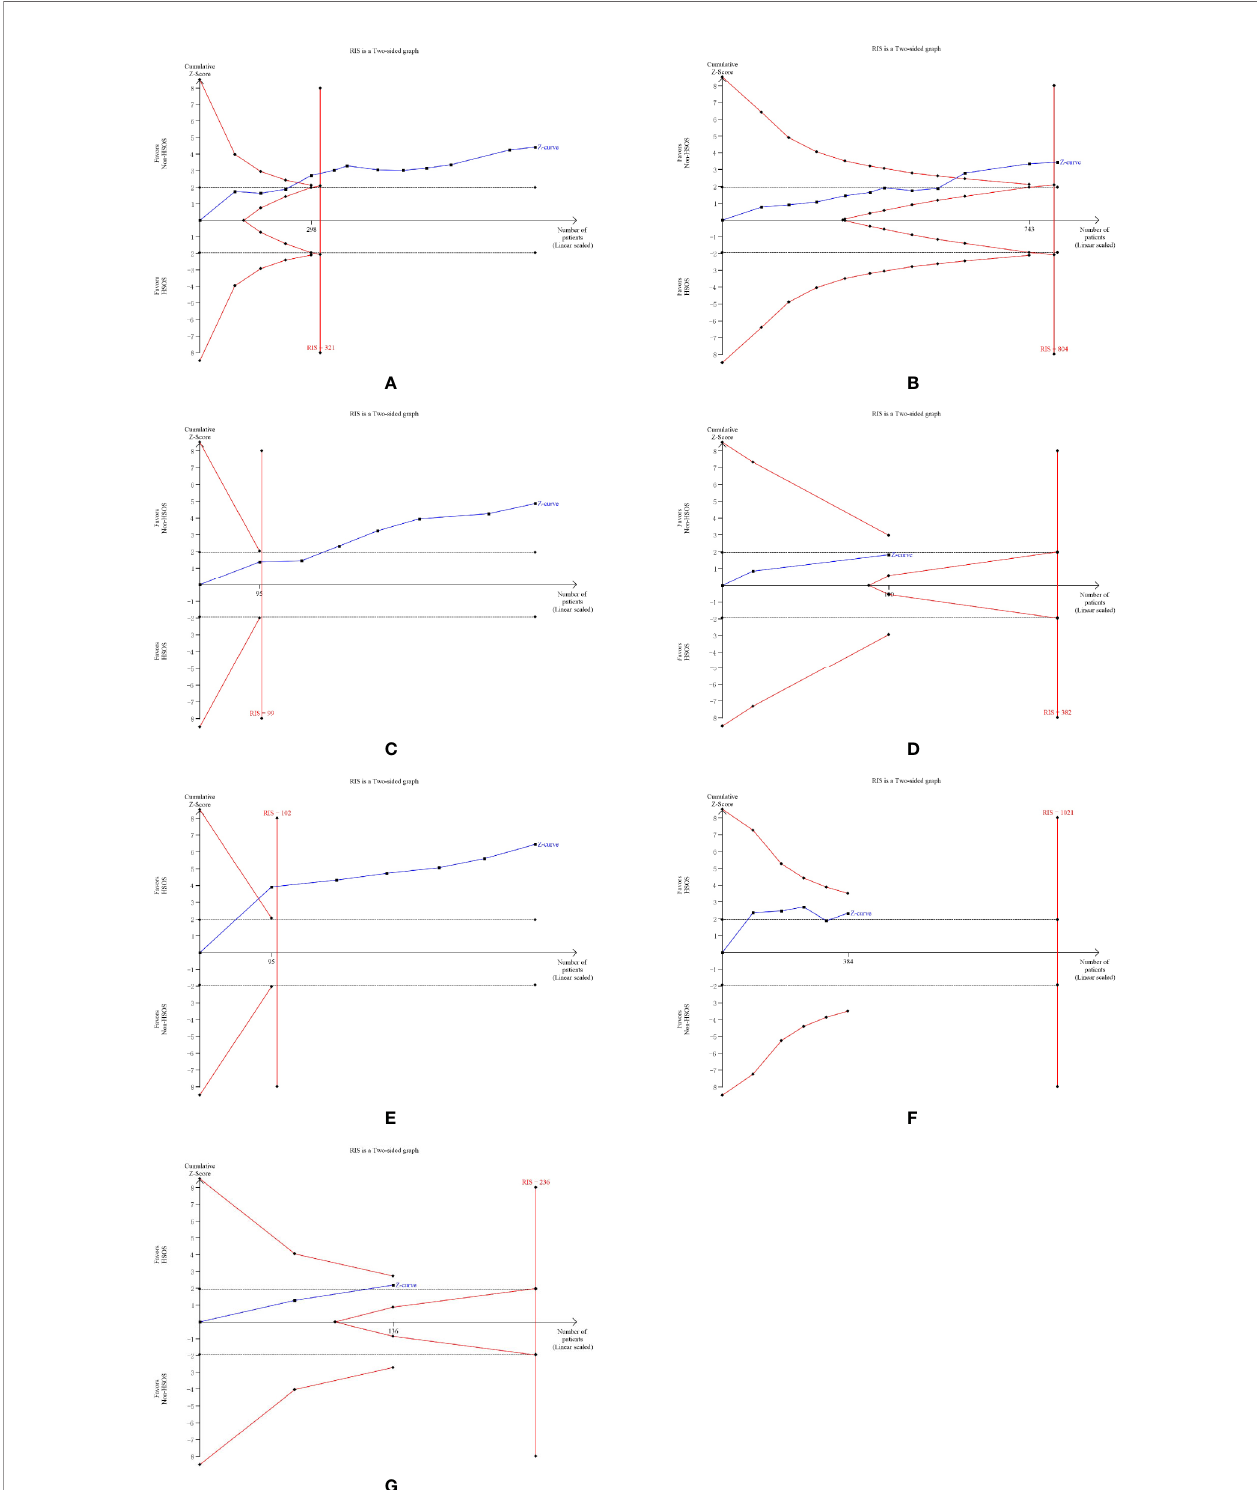
FIGURE 12 | Trial sequential analysis. (A) Objective tumor response. (B) Disease control rate. (C) KPS. (D) One-year survival rate. (E) White blood cell toxicity. (F) Platelet toxicity. (G) Vomiting